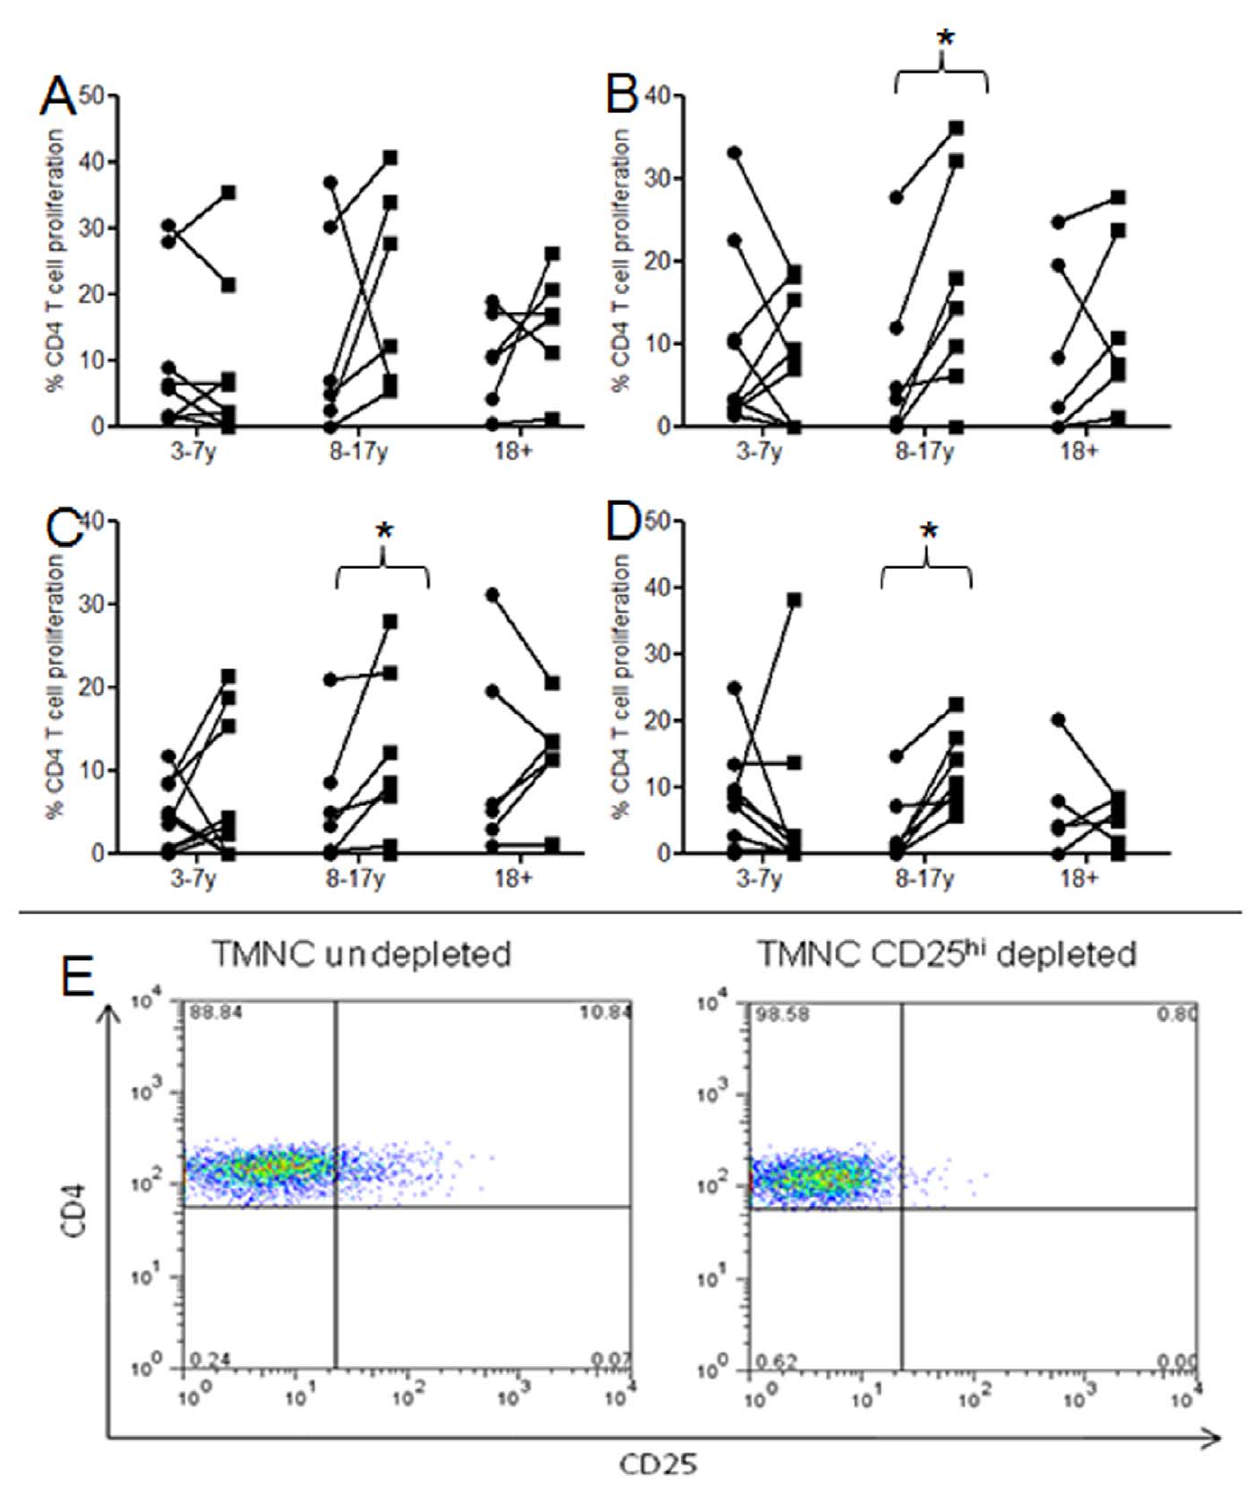
Figure 2. Inhibition of pneumococcal, influenza and MTB responses by regulatory T cells in young children and onwards. Mucosal CD4 T cell responses to pneumoCCS ( a ) and PlyCCS ( b ) influenza ( c ) and MTB PPD ( d ) by CD25 hi regulatory T cells in subjects above 3 years old as indicated by increased cell proliferation following depletion of CD25 hi cells from tonsillar MNC population. Subjects (n=22) were grouped into those aged 3–7 yrs, 8 to 17 yrs and . 18 yrs. Individual subject’s proliferative response pre ( circle ) and post CD25 hi cell depletion ( square ) are shown with a connecting lines. Data was analyzed using Wilcoxon signed rank test, *=p , 0.05. Representative flow cytometric plot of CD25 undepleted and depleted tonsillar mononuclear cells (TMNC) ( e ).